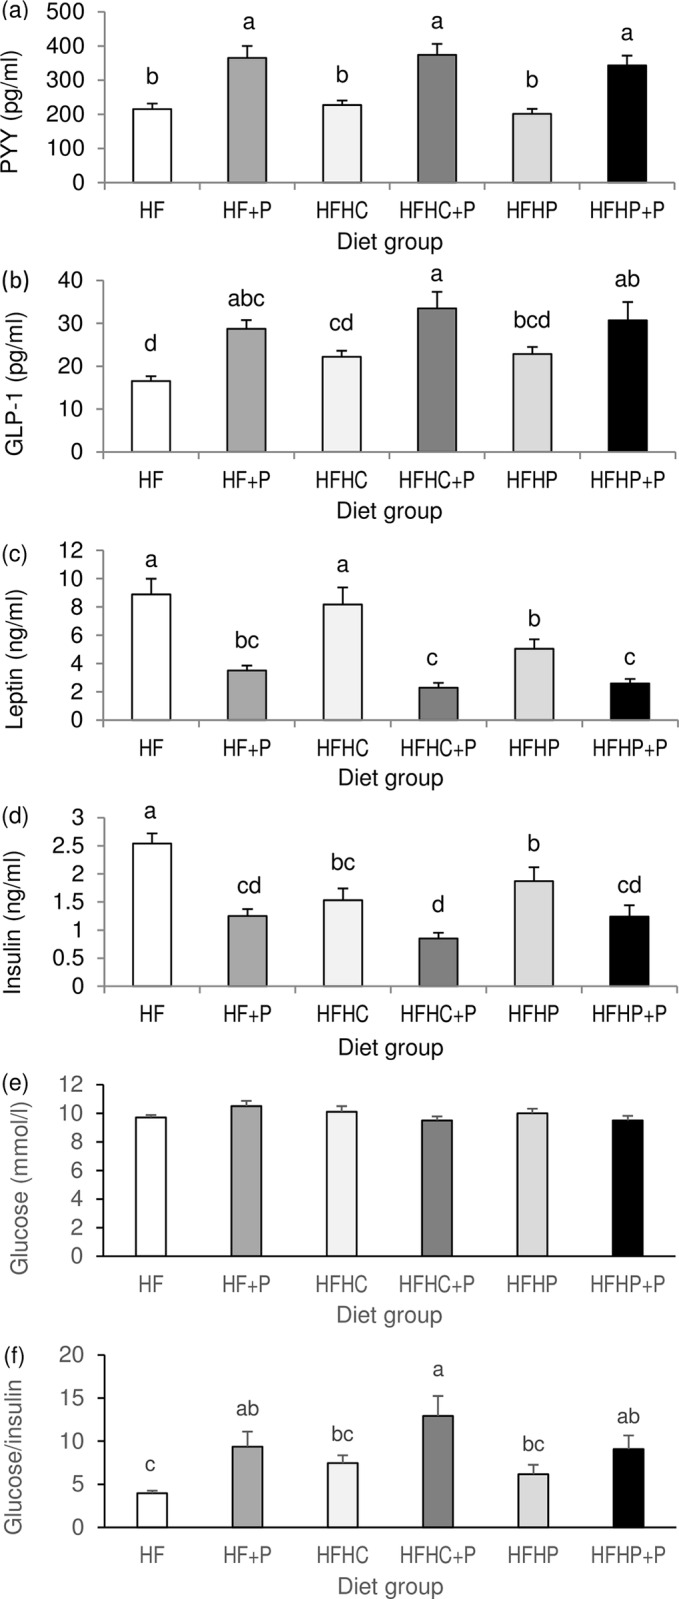
Plasma hormones and glucose.Final plasma concentrations of (a) PYY, (b) total GLP-1, (c) leptin, (d) insulin, (e) glucose, and (f) glucose/insulin ratio in DIO rats fed high fat diet (HF), high fat diet with pectin (HF+P), HF with high casein protein (HFHC), HFHC with pectin (HFHC+P), HF with high pea protein (HFHP), HFHP with pectin (HFHP+P) for 4 weeks (n = 8 per group). Statistical analysis by two-way ANOVA with pectin, protein and their interaction as factors, followed by Fisher pairwise comparisons. Within figures, values labelled with different letters are significantly different (P < 0.001).